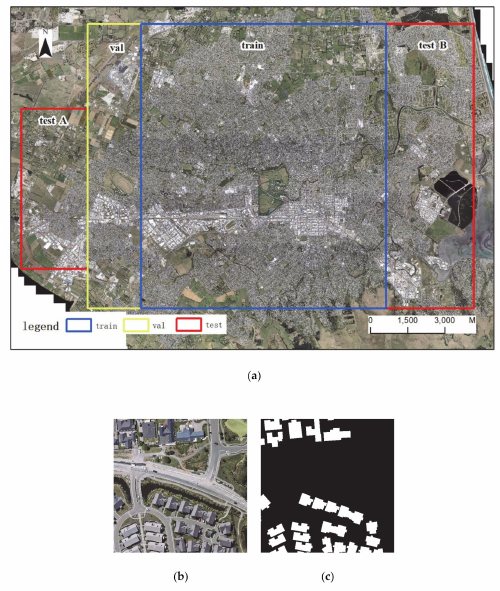
Figure 1. The WHU building data set. ( a ) shows the region of the RSI covering. The training area is the blue box, valid area is in the yellow box and test areas are in red boxes (containing test A and test B). ( b , c ) show image tile and label with size 512 × 512 pixels,